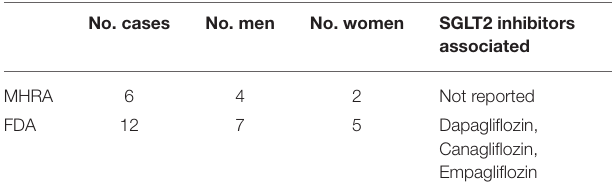
TABLE 2 | The number of cases of Fournier’s Gangrene associated with the use of SGLT2 inhibitors reported from both the Medicines and Health Regulatory Agency and the Food and Drug Administration